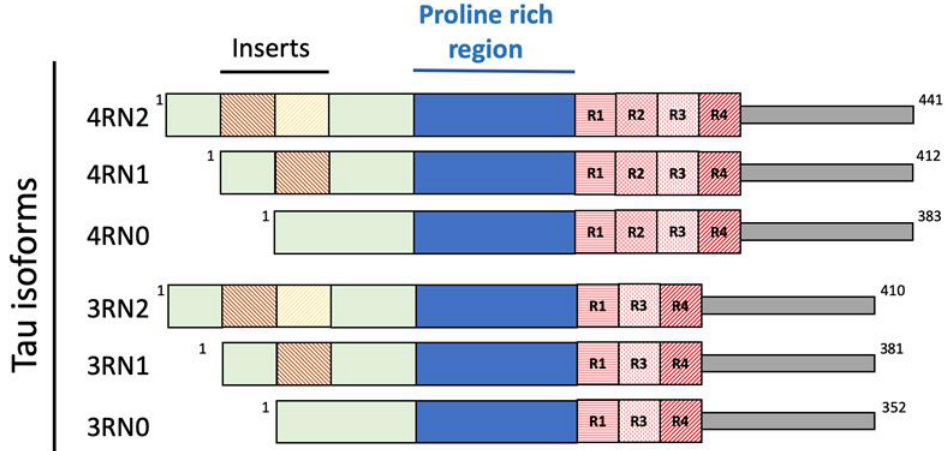
Figure 3. Results of the different human MAPT gene splicing in the expression of Tau isoforms.